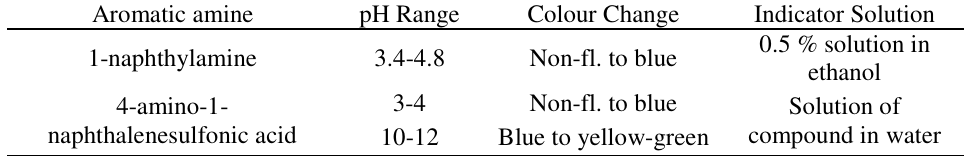
Table 2. Acid-base fluorescent aromatic amine